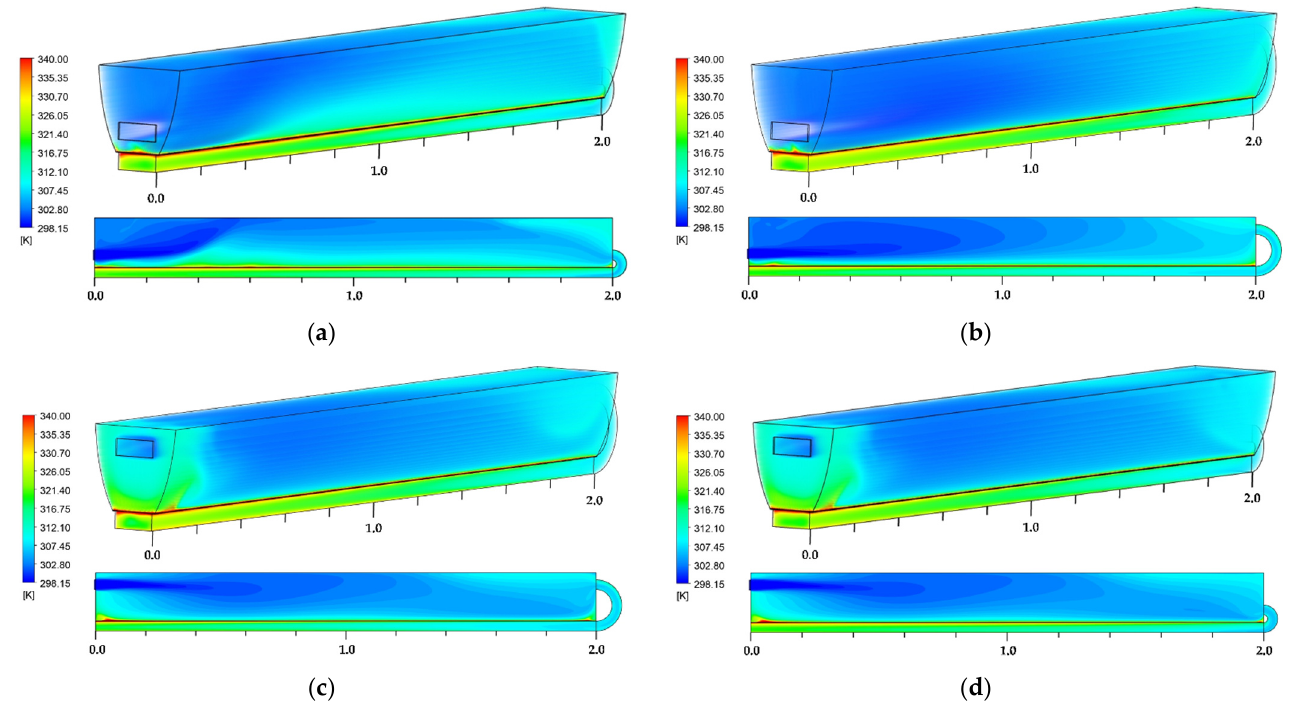
Figure 6. Air temperature fields at the collector cross-section with air mass flow 1: 0.01 kg/s. ( a ) Down–Down; ( b ) Down–Up; ( c ) Up–Up; ( d ) Up–Down.